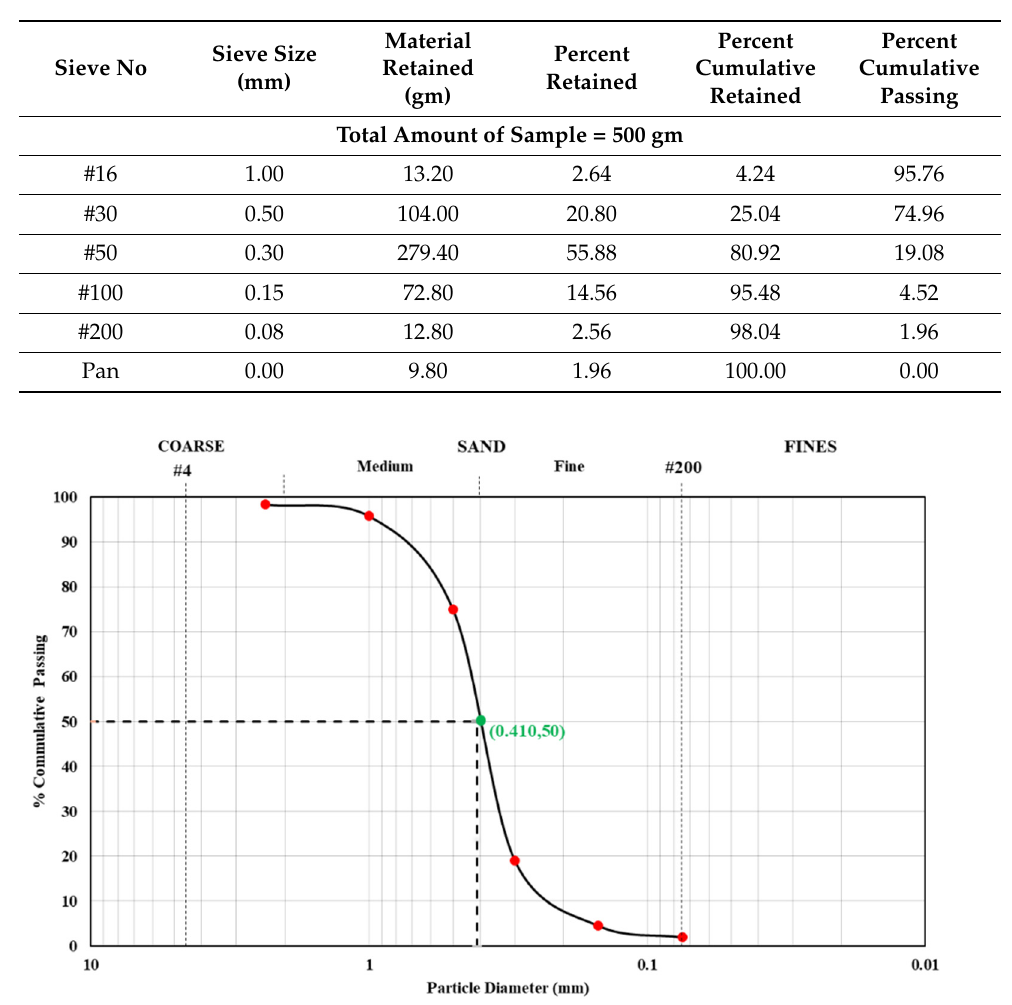
Figure 3. Sieve Figure 3. Sieve analysis.